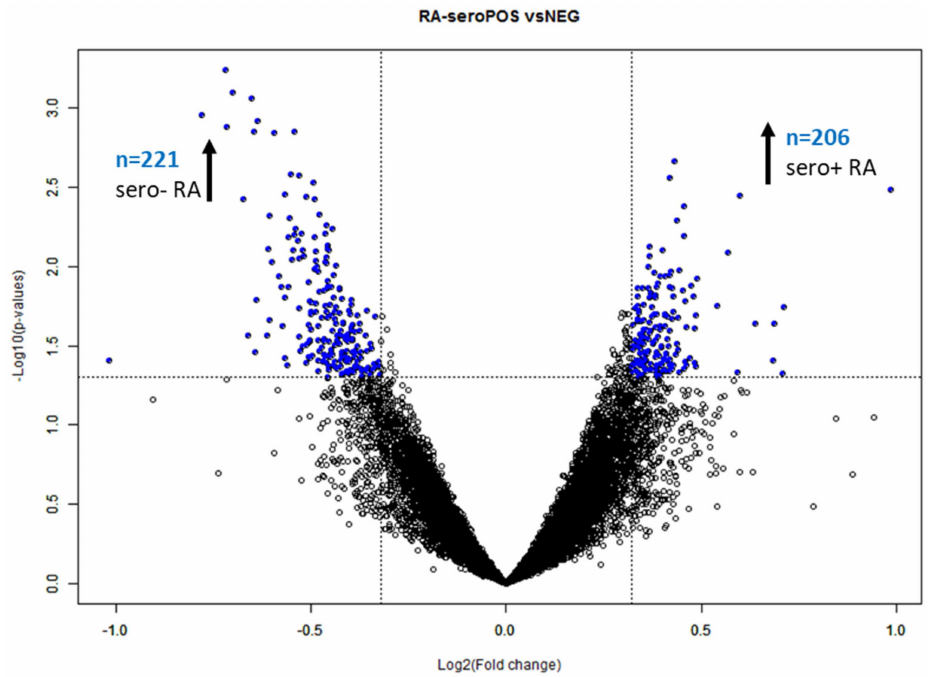
Figure 2. Volcano plot of seropositive versus seronegative RA. The unblocked class comparison elucidated n = 382 significant ( p < 0.05) DIRAGs with a fold-change > 1.25 ( − 0.3219 and 0.3219 on the log2 scale, indicated as dashed line in the plot above). DIRAGs above the significance thresholds are indicated in blue (BRB ArrayTools [8] output per default). The sign of the fold-change is assigned in alphabetical order; hence, proteins higher reactive in seropositive RA are located on the left side of the